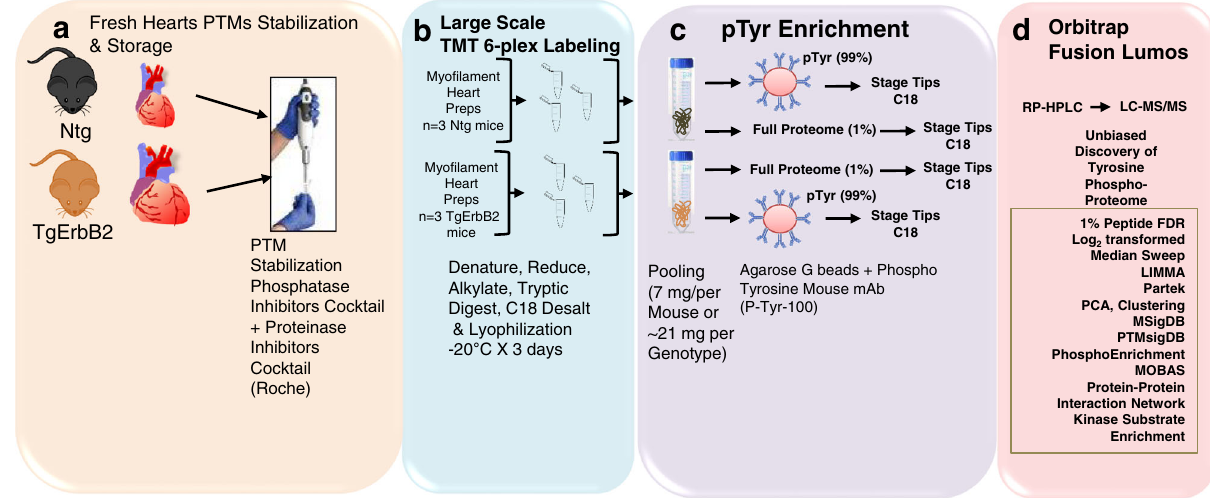
Fig. 4 Work fl ow for cardiac sarcomere pTyr identi fi cation of normal and TgErbB2 hypertrophic myo fi laments by TMT quantitative proteomics. a Myo fi lament from Ntg ( n = 3) and ErbB2 ( n = 3) transgenic mice hearts were freshly isolated on ice-cold buffers containing Proteinase and Phosphatase Inhibitors Cocktails (Roche). b All material was resuspended in TEAB, then reduced and alkylated. Tryptic peptides were desalted and labeled with 6-plex isobaric tandem mass tags (TMT). c The digested and labeled peptides were pooled and desalted with C 18 SEP-PAK. The enrichment for phosphotyrosine was performed with PTMScan Phospho-Tyrosine Rabbit mAb ( P -Tyr-1000) kit (Cell Signaling Technology). The eluted peptide samples were desalted using C18 STAGE tips d Easy-nanoLC 1200 nano fl ow liquid chromatography system coupled to Orbitrap Fusion Lumos